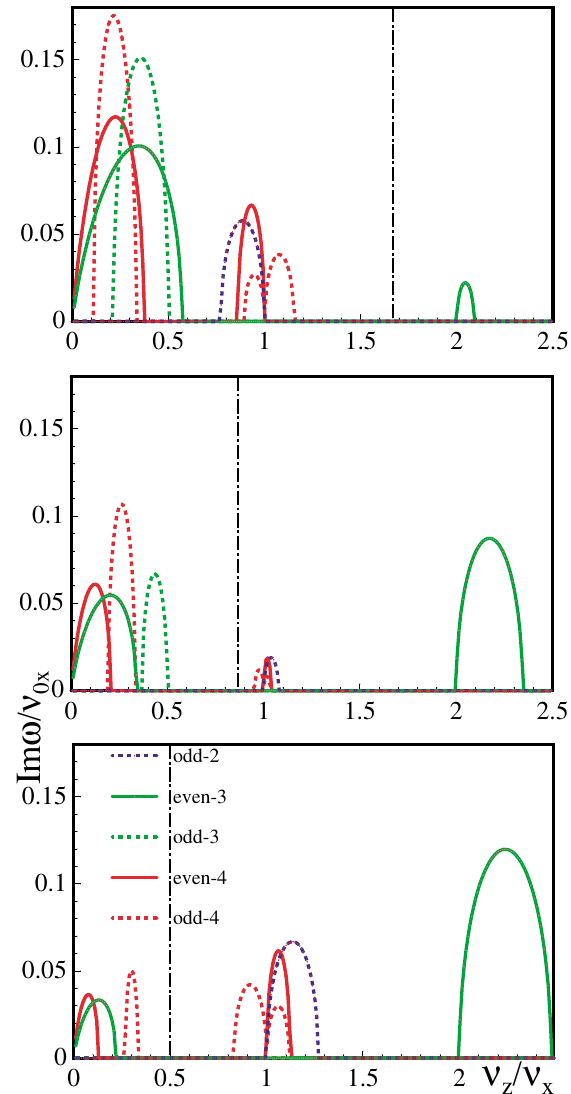
FIG. 5. (Color) Analytic instability growth rates (normalized) for constant (cid:10)